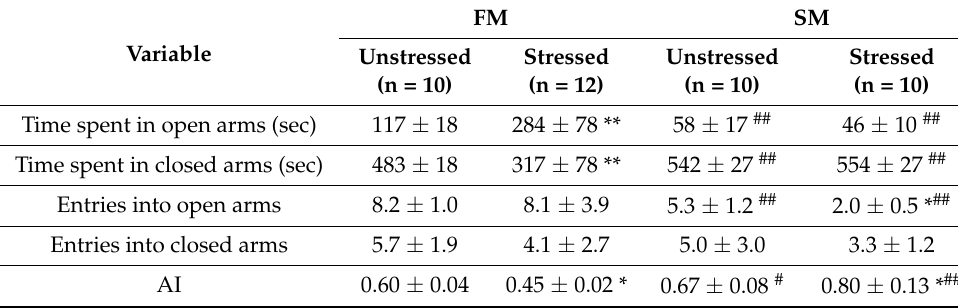
Table 1. Effect of PS on behavior of FM and SM rats in EPM.